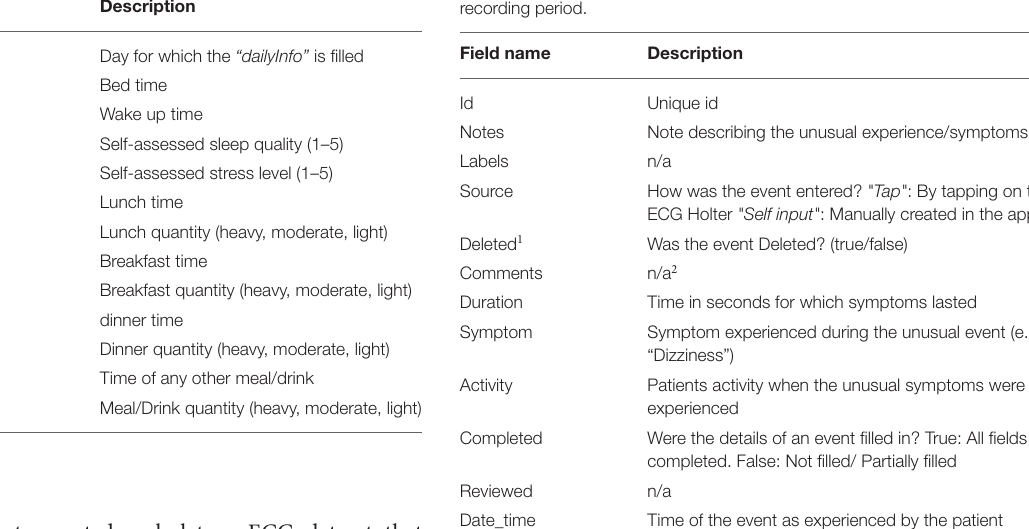
patient-reported symptoms that the patient may have experienced during the recording